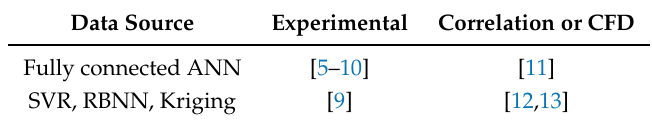
Table 1. Published work on thermal-hydraulic heat exchanger modeling using machine learning